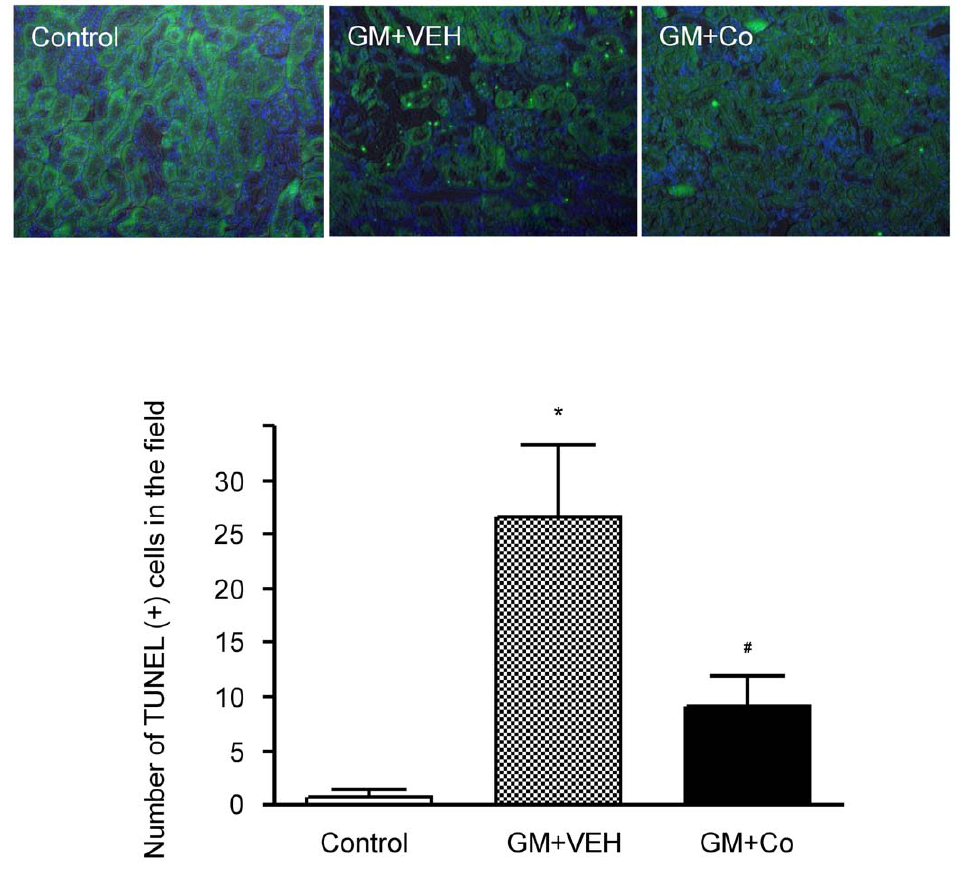
Figure 6. Effects of gentamicin and cobalt on apoptosis in rat kidneys. Apoptotic cells in the kidneys of experimental animals were detected using TUNEL staining. The results are expressed as the mean 6 s.d. *Significantly different with respect to control rats. # Significantly different with respect to the rats treated with gentamicin and vehicle. * # P , 0.05. GM + VEH, gentamicin and vehicle treatment; GM + Co, gentamicin and cobalt treatment. Magnification 6